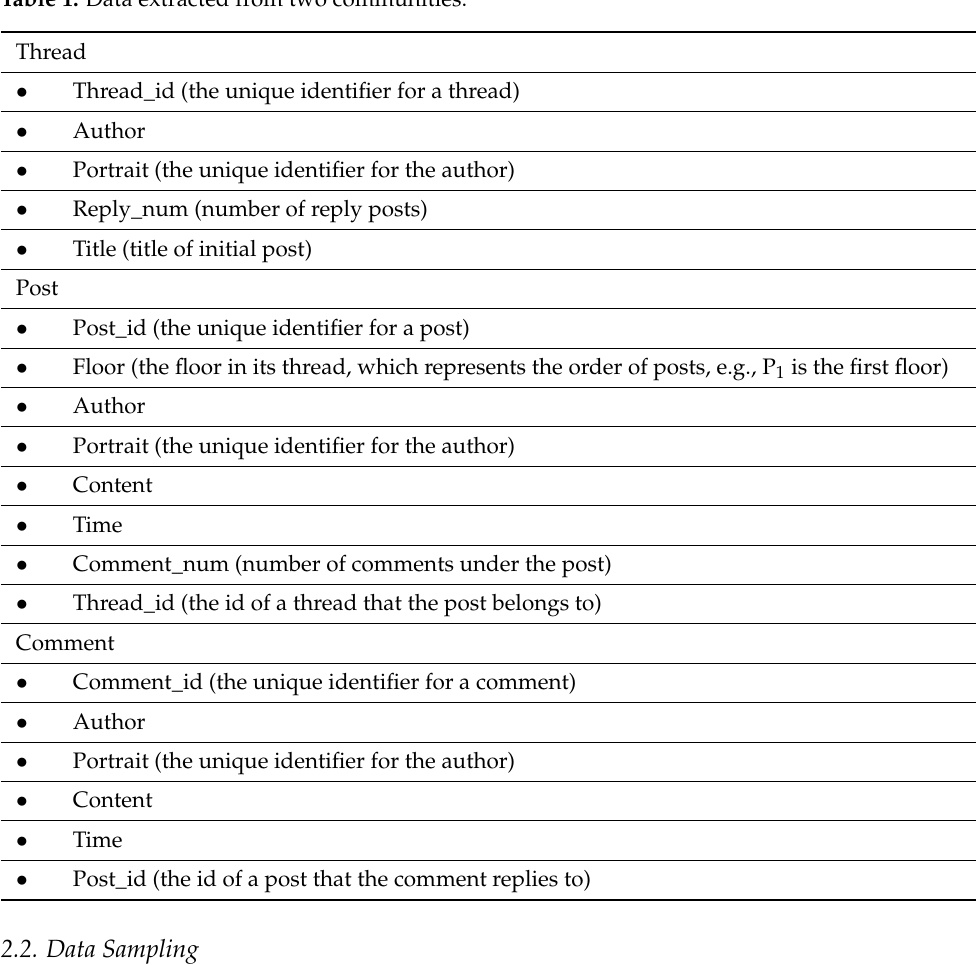
Table 1. Data extracted from two